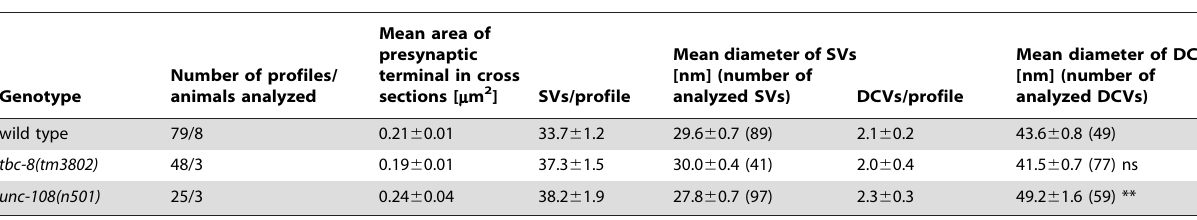
Table 1. SV and DCV analysis determined by HPF